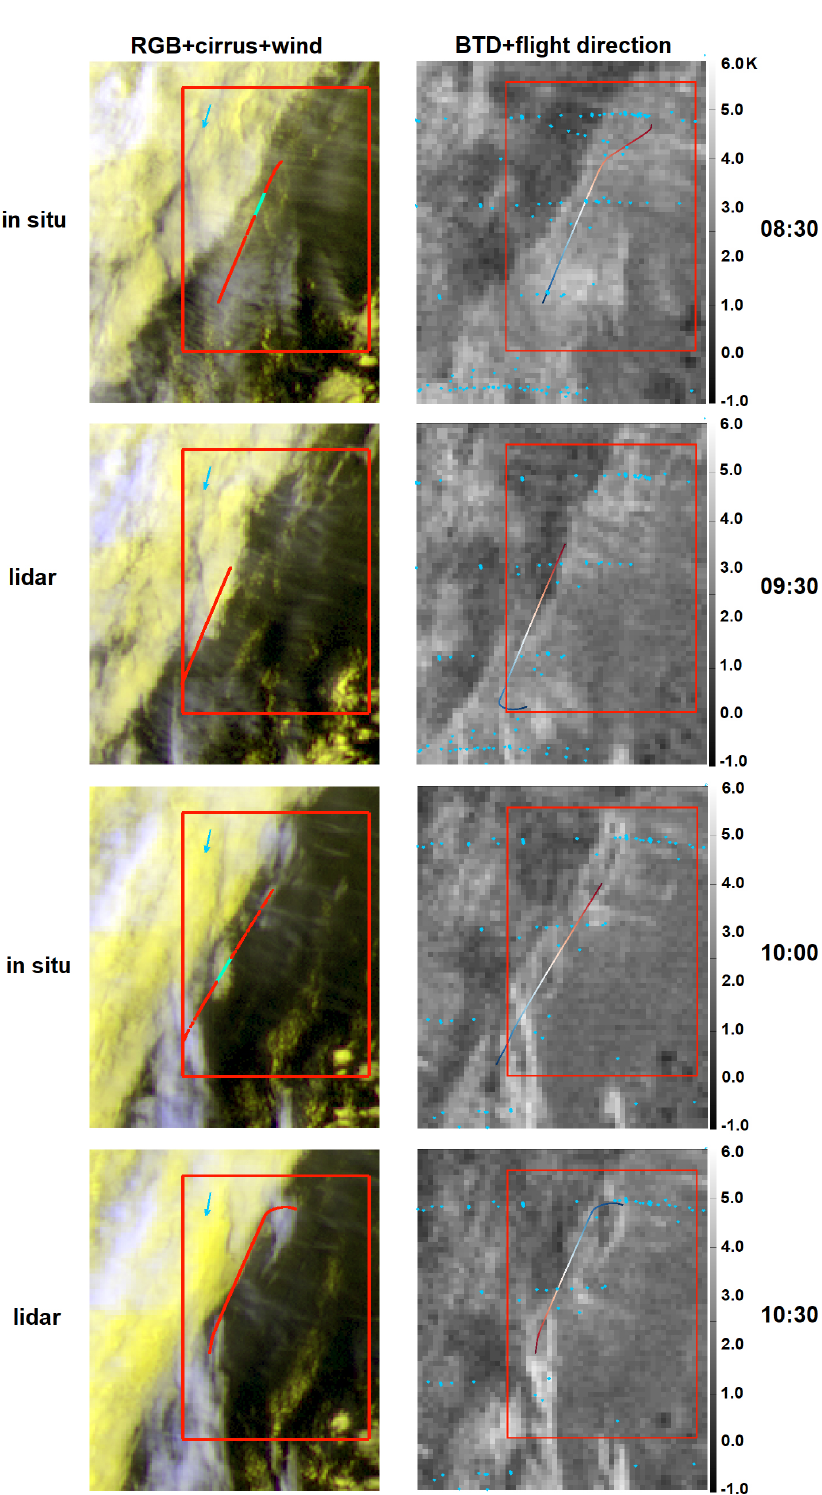
Figure 2. Time series of contrail cirrus and surrounding clouds from MSG/SEVIRI observations over the NAR corridor on 26 March 2014. The first column shows RGB composite with overlaid cirrus, low-level liquid clouds pixels and in situ/lidar HALO leg at close time. The red and green lines of the HALO flight track represent contrail cirrus and natural cirrus, respectively. The blue arrow indicates the wind direction almost perpendicular to the line-shaped structures of the contrail cirrus. The second column shows 10.8µm and 12.0µm BTD (K) with overlaid cirrus pixels. Blue points show air traffic data set interpolated to MSG grid from EUROCONTROL’s Model 3 (M3) and North Atlantic Tracks (NATS). The color of the HALO flight track indicates the flight direction. HALO flies from the red to the blue part. Top to bottom is 08:30, 09:30, 10:00 and 10:30UTC. The red area is investigated in Sect.